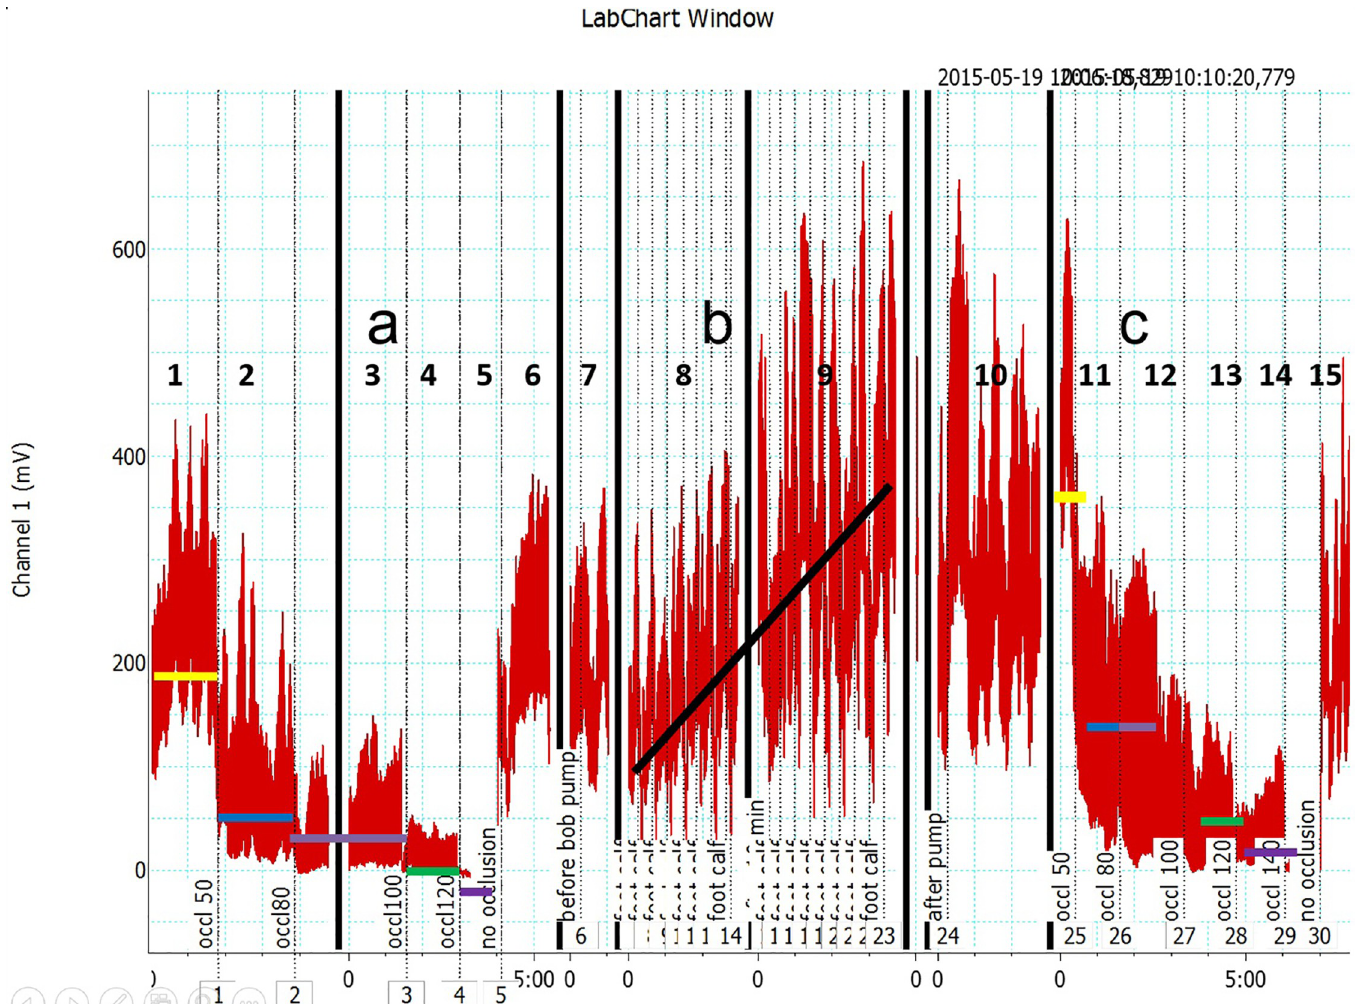
Fig 4. Laser Doppler recording of the big toe capillary flow velocity (in millivolts) part a) before (points 1–5), no assist (points 6–7), part b) during (points 8–9), no assist (point 10), part c) after (points 11–14), and no assist (point 15) Biocompression arterial pump application in a patient with multifocal calf arteries occlusions. In order to observe the pump effect on the capillary flow before and after IPC the venous occlusion plethysmographic method was used at venous occlusion pressures from 50 through 80, 100, 120 and 140 mmHg, before (points 1–5) and after (points 11–14) 20 arterial pump inflations. Horizontal lines at these points denote mean values. Oblique line in part b point 8 and 9 shows values during pump inflations. Note that capillary flow velocity remained increased after pump assist. Comparison of the pre- and post-IPC capillary flow velocity values showed their higher values after assist even at the plethysmographic arterial inflow occlusion as high as 140 mmHg.